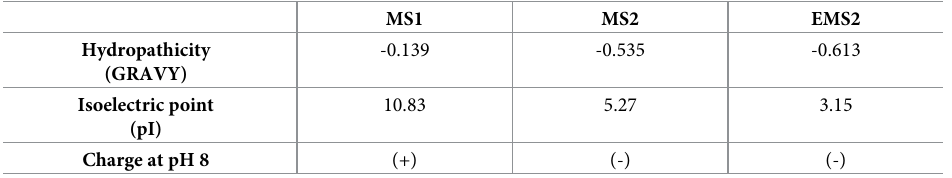
Table 1. The properties of the bioengineered spider silk proteins MS1, MS2 and EMS2 predicted on the basis of their amino acid